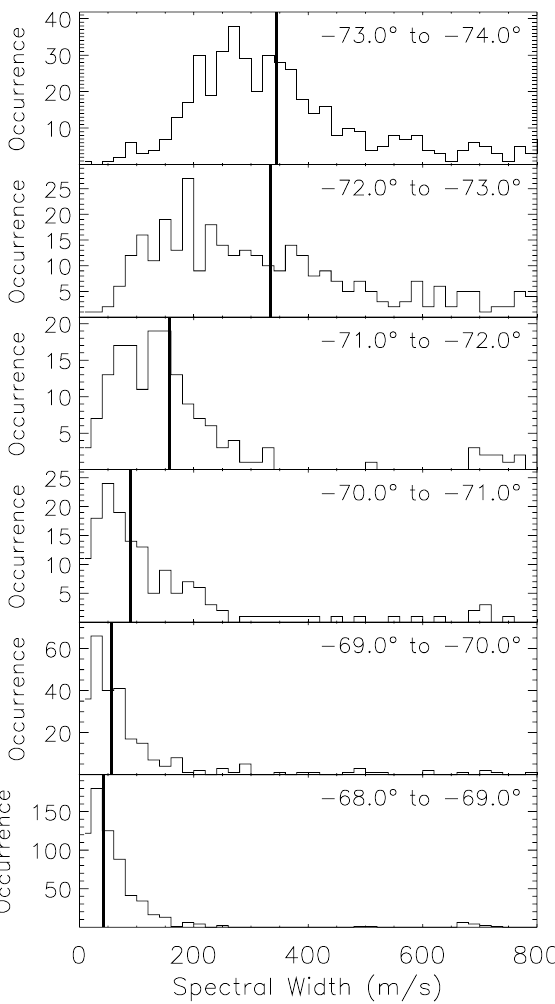
Fig. 4. The distributions of spectral width from all beams of the Halley radar measured during the interval 13:56–14:28 UT (interval B) on 14 August 1998. The distributions have been split into 1 ◦ latitude bins from − 68 ◦ to − 74 ◦ . The bold vertical lines represent the medians of each distribution.